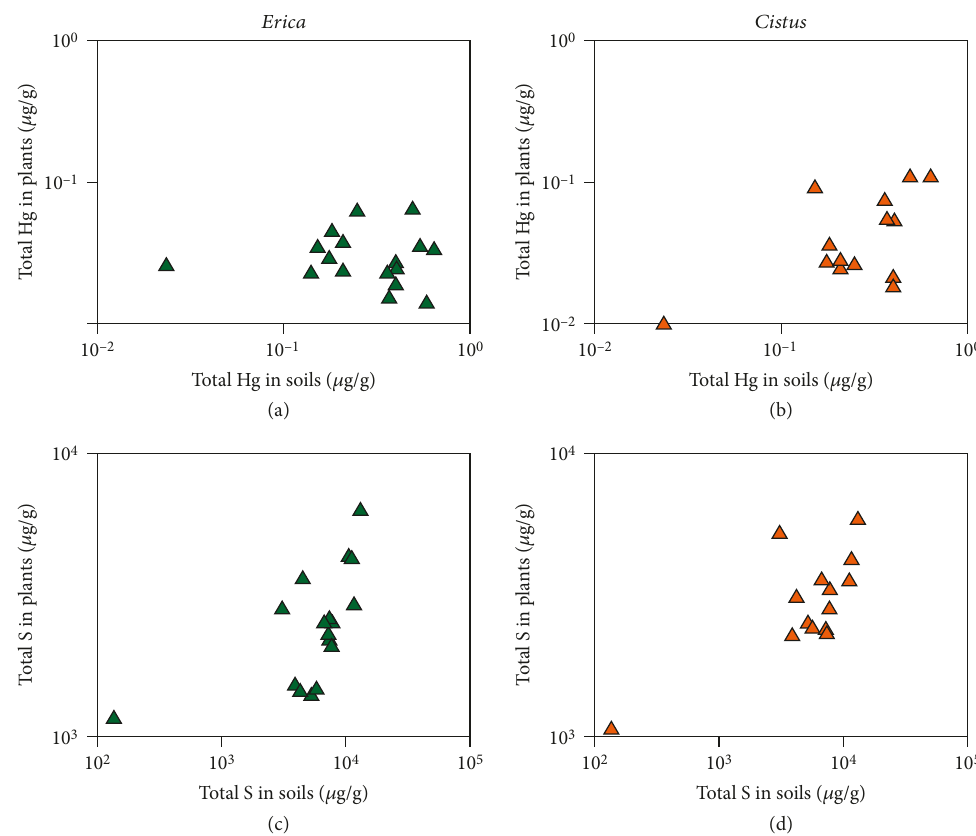
Figure 8: Correlation plots that present in the upper part the total Hg concentrations in soils and (a) Erica and (b) Cistus and in the lower part the total S concentrations in soils and (c) Erica and (d) Cistus collected in the Lakki